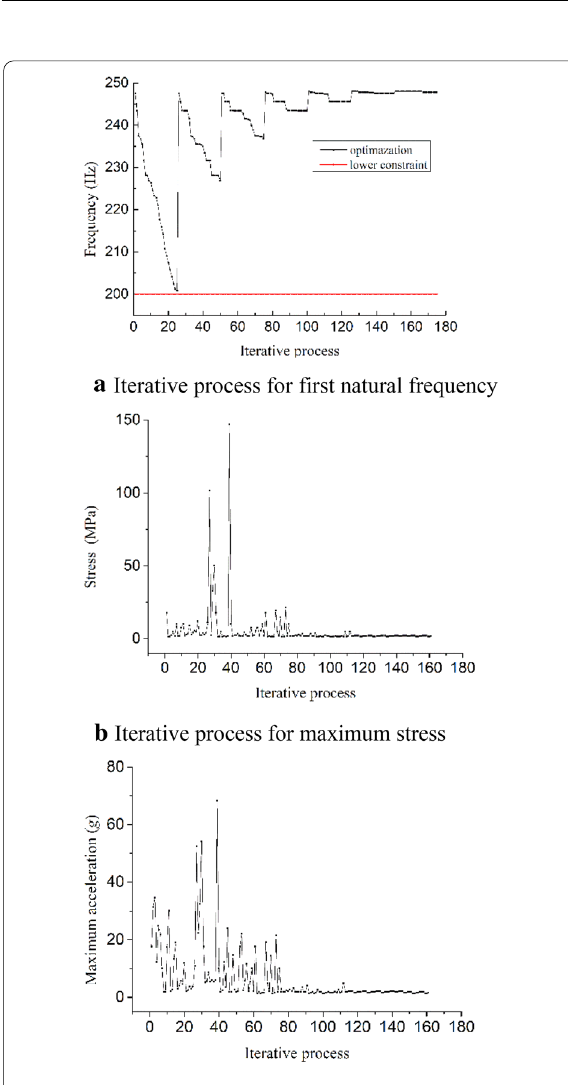
Figure 7 Iterative process for optimization calculation. a Iterative process for first natural frequency. b Iterative process for maximum stress. c Iterative process for maximum